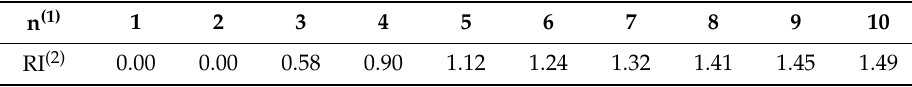
Table 5. Random Index for the calculation of consistency ratio